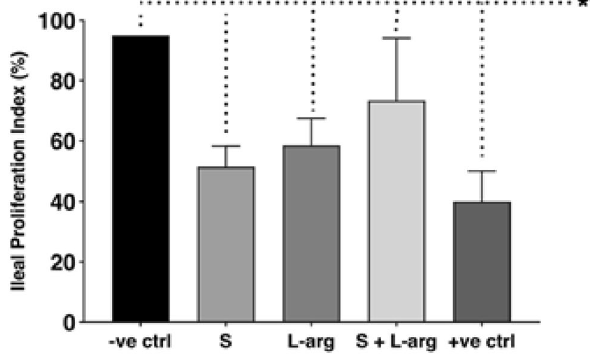
Figure 4. Mean proliferative index of groups. Groups: A—negative control (− ve ctrl), B—sildenafil (S), C—l- arginine (l-arg), D—sildenafil and l-arginine (S + l-arg) and E—positive control (+ ve ctrl) (Kruskal–Wallis, p =